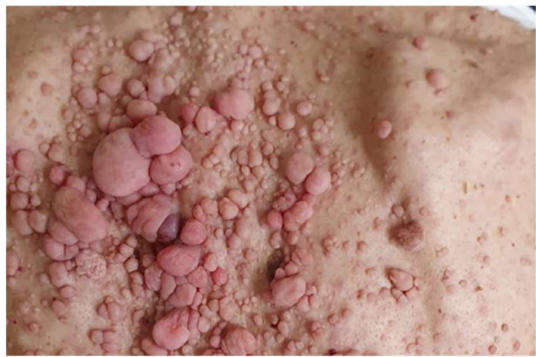
Figure 1. A 64-year-old male patient with NF1: multiple and variable-sized cutaneous neurofibromas of his back.